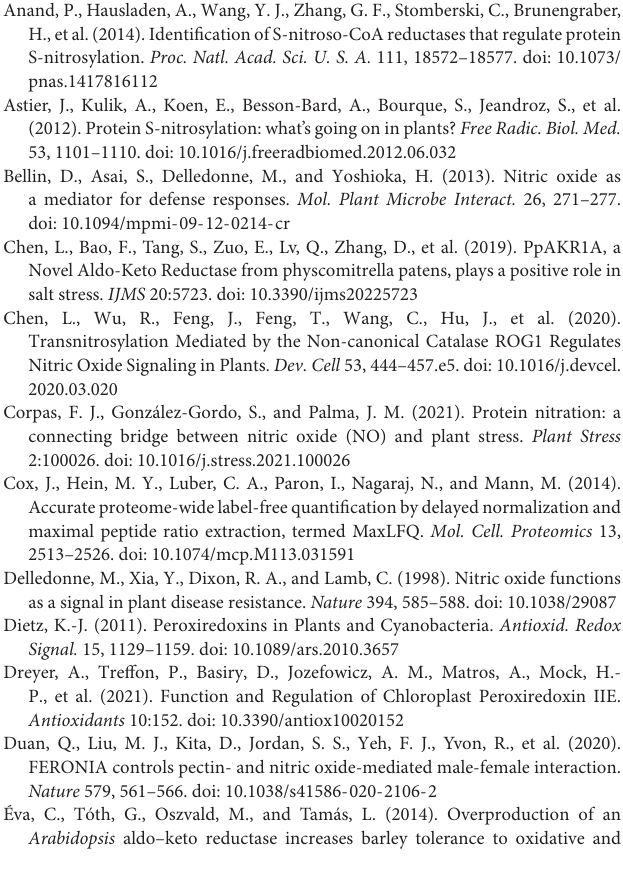
AKR4C11) proteins. Red boxes denote the catalytic tetrad residues, while green, cyan, and red bars highlight the flexible loops defining the active site important for substrate specificity. Highlighted in yellow are the residues that are conserved among the mammalian and plant AKR proteins. Supplementary Figure 5 | Expression of AKRs. (A) Expression profile of A. thaliana GSNOR, AKR4C (C8, C9, C10, and C11), and other AKR genes identified in the Panther database for A. thaliana (AGIs: AT1G59950, AT1G59960, AT2G21250, AT2G21260, AT5G01670, and AT5G62420). Selected data are obtained from the perturbations AT_AFFY_ATH1-0 database (perturbations) using Genevestigator (https://genevestigator.com/). (B) AKR4C protein expression of 10-day old WT Col-0 seedlings treated with NO donors as mentioned in section “Materials and Methods.” Seedlings were treated for 3 h with a single high dose of NO donors (DETA/NO, GSNO) with or without CPTIO and DETA as negative controls. Total proteins (30 µ g) were then extracted and subjected to immunoblot analysis using AKR4C8 and actin antibodies as loading control. Purified AKR4C8 protein (5 ng) was used as an additional control. Shown is a representative result from three independent experiments. Supplementary Table 1 | Primers used in this study. Supplementary Table 2 | Percent amino acid sequence identity/similarity of A. thaliana AKR proteins with greatest homology to human AKR1A1 as determined by BLAST. AGI numbers in red are those proteins identified in the proteomics dataset. Highlighted in blue are the percent identity/similarity of AKR4Cs in comparison to human AKR1A1. Data were assessed using Emboss Needle (https://www.ebi.ac.uk/Tools/psa/emboss_needle/) and the EBLOSUM62 matrix with default parameters. Values were rounded to the nearest